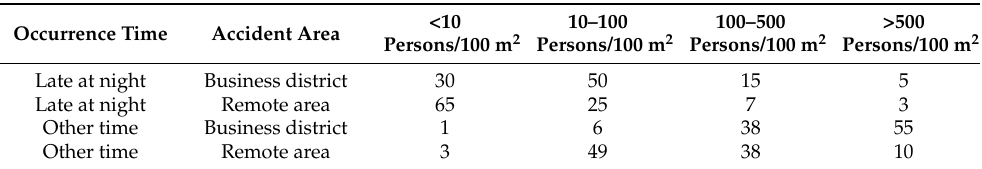
Table 7. Conditional probability table for threatened persons after urbanization.